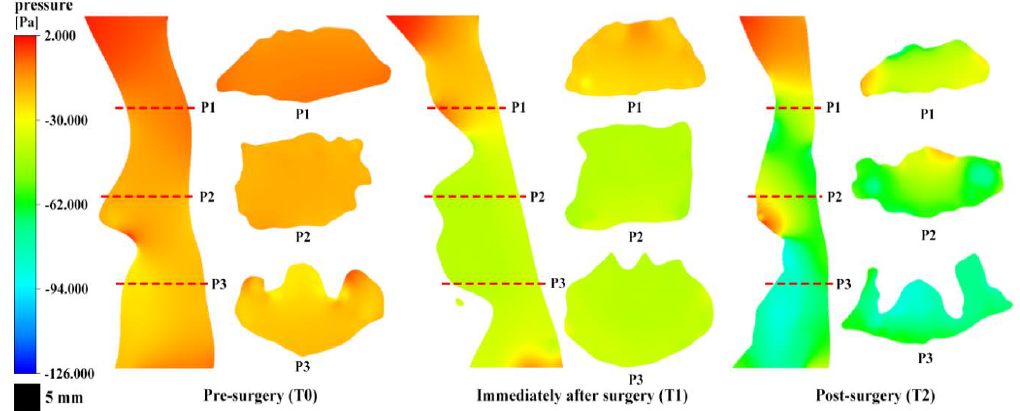
Figure 4. Simulation results representing contoured pressure distribution of air flow in cases of pre-surgery, immediately after surgery, and post-surgery. P1, P2, and P3 indicate xz planes representing sectional information.